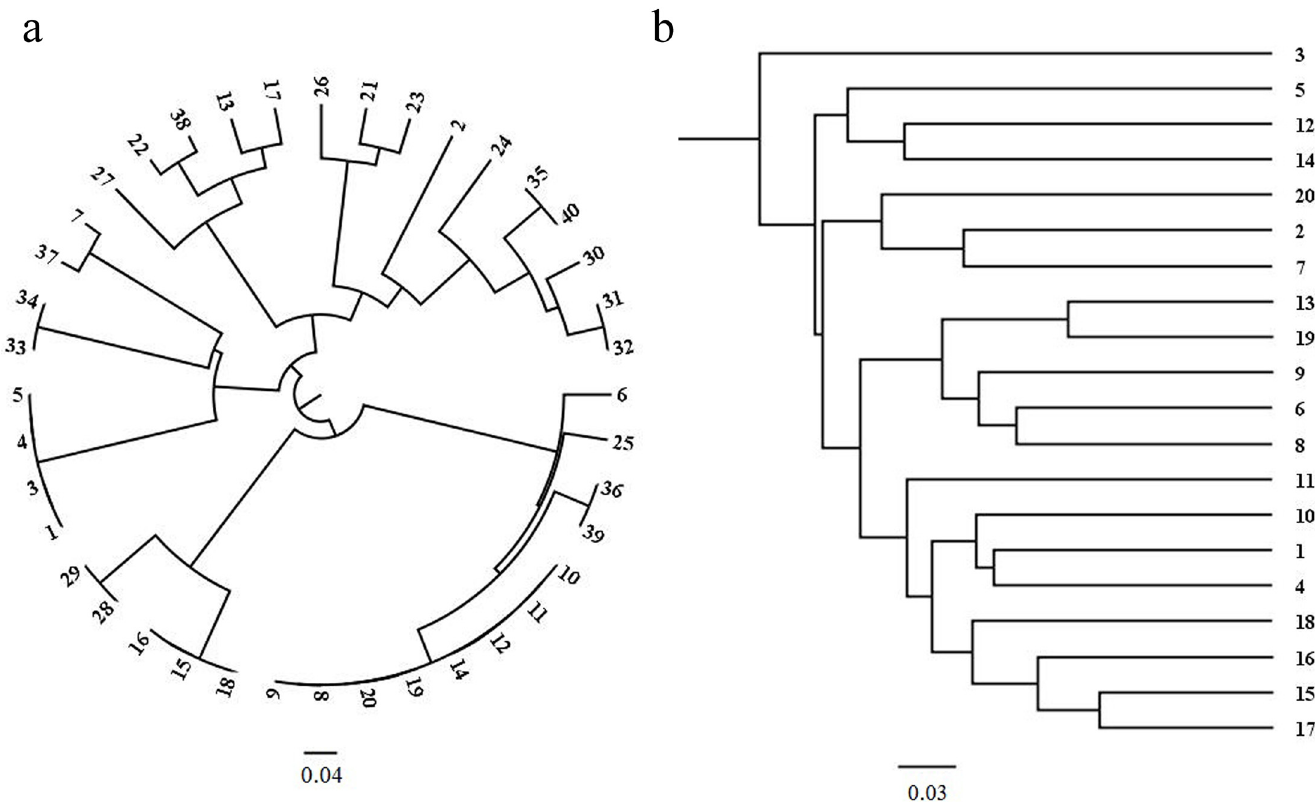
Fig 3. Phylogenetic trees of superior individuals in the second-generation ZN-NP (a) and XX-OP (b) selected populations of Chinese pine.